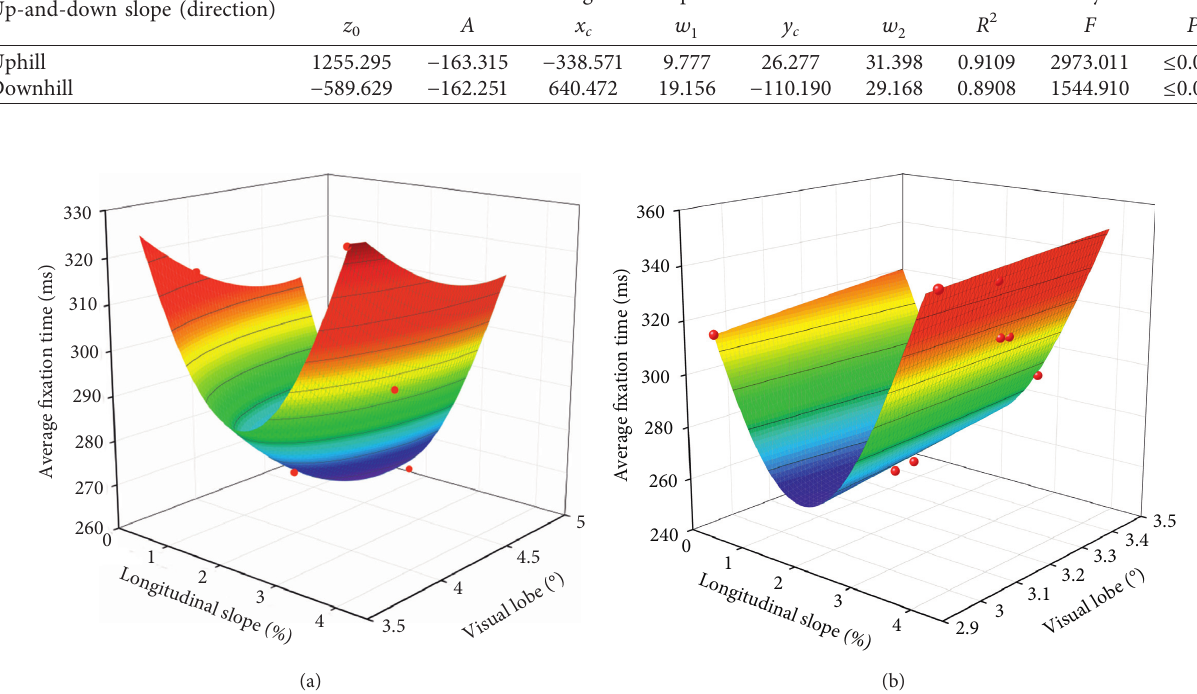
Figure 4: The variation rule of the longitudinal slope of the uphill and downhill section, average fixation time, and visual lobe. (a) Uphill. (b)